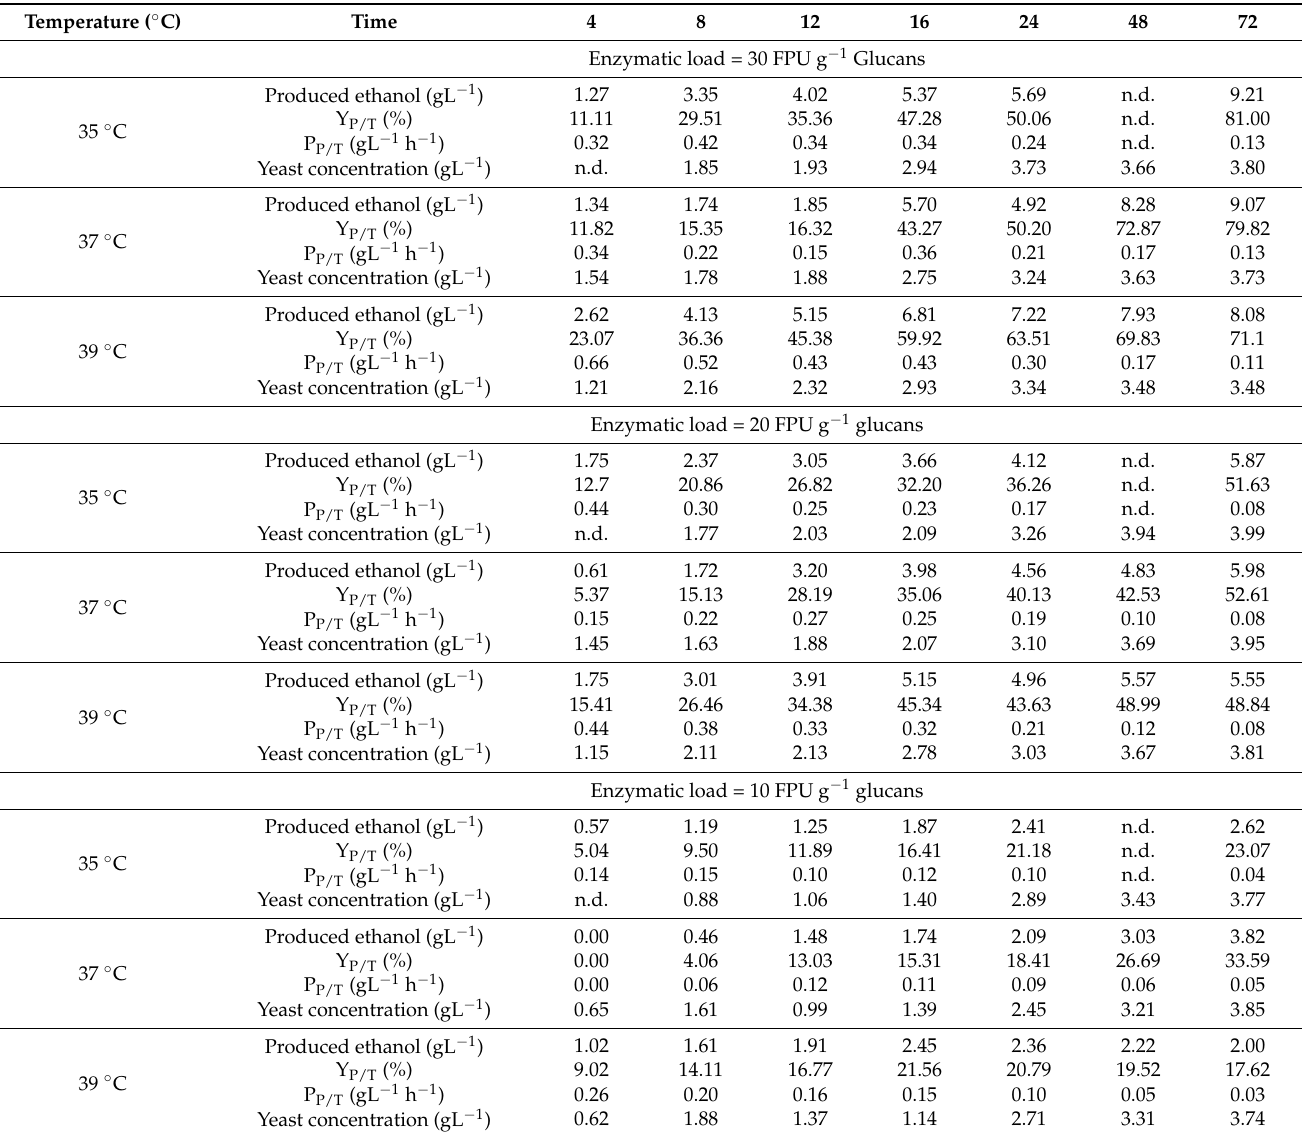
Table 3. Bioethanol yields results obtained through the Simultaneous Saccharification and Fermenta- tion (SSF) of a pine sawdust soda-ethanol pulp (theoretical bioethanol 11.36 gL − 1